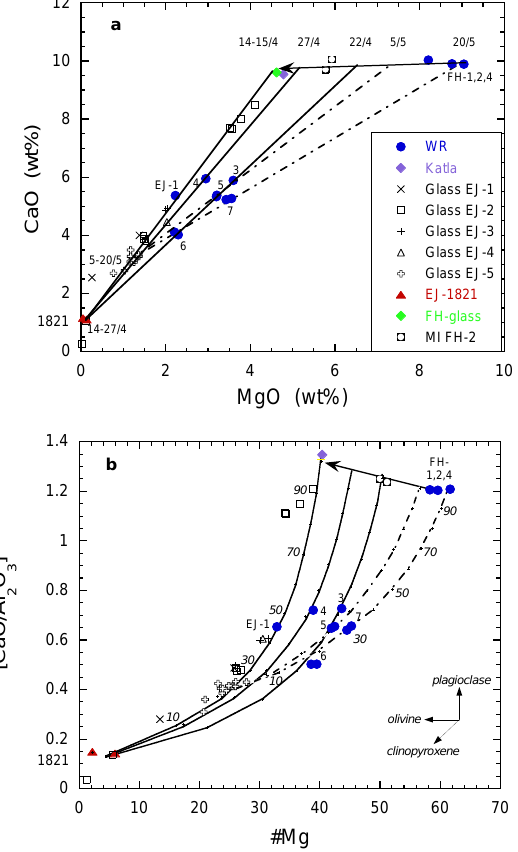
Fig. 3. Major-element variations in 2010 Eyjafjallajökull tephra and lava. (a) CaO versus MgO showing a near-horizontal fractionation vector from Fimmvörðuháls whole-rock (WR) basalt compositions (samples with prefix FH) to that of the corresponding interstitial glasses and Katla 1918 basalt glasses (Óladóttir et al., 2008). Mix- ing lines between these evolved basalt compositions (MgO ∼ 4.5; ing poles. (b) Molar ratios of CaO over Al 2 O 3 against the Mg- number (#Mg = molar MgO over the sum of MgO plus FeO cal- culated from total iron analysed by assuming Fe 2 O 3 /FeO of 0.2). In the lower right corner are shown schematically the melt compo- sition vectors of pure mineral fractionation from basalt. These are consistent with olivine domination on the fractionation vector from FH-basalt, but the trend of EJ-2 basalt glasses indicates clinopy- roxene fractionation. Binary mixing curves are calculated using the same end-member composition as in (a) . Mingling and mixing proportions of basalt to silicic melt are derived from the calculated curves. Duplicate analyses of three Eyjafjallajökull bulk-tephra (EJ- 5, 6, 7) indicate the overall analytical precision. Abbreviations are WR for whole-rock compositions, EJ for Eyjafjallajökull, FH for Fimmvörðuháls flank basalts and MI for melt inclusions.